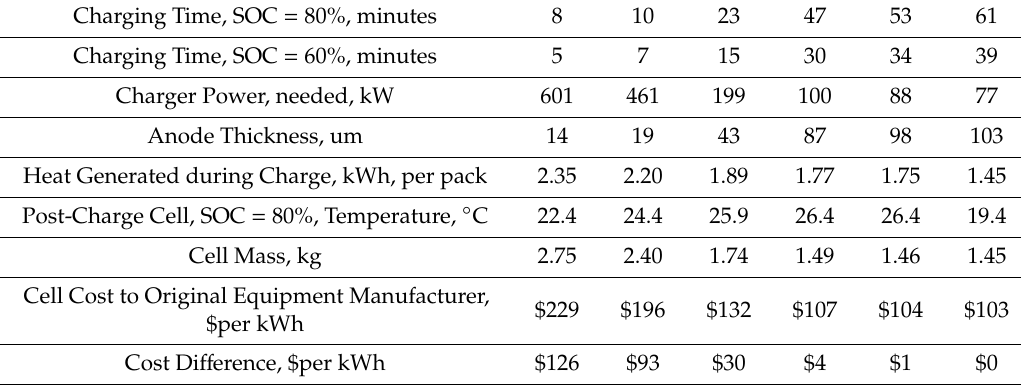
Figure 2. The summary of relationship between Rion and electrode thickness ( a ) [15]. Discharge capacity as a function of electrode loading (mAh / cm 2 ) and charge rate ( b ) and photos of lithium deposits on representative graphite electrodes ( c ) [19]. Constructions of the conventional electrode design and center-tab design (The left is named cell A and the right is named cell B) ( d ); discharge profiles (1 C, 5 A, 10 A, 15 A, and 20 A) of cell #A and #B ( e ) [16]. Reproduced by permission of Royal Society of Chemistry, Elsevier, and The Electrochemical Society. Table 1. Bat PaC simulation comparing the e ff ects of charging time on the required anode thickness, the heat generation in the pack and the resulting temperature rise, the pack cost, and the incremental cost of charging faster than 1-C (60 min) rate. Cell Chemistry: NMC622-Graphite, Pack Energy: 85 kWh; Rated Power (10 s burst): 300 kW; MACD (Maximum Allowable Current Density): 4 mA cm 2 ; no. of cells per pack: 240 [5]. Reproduced by permission of